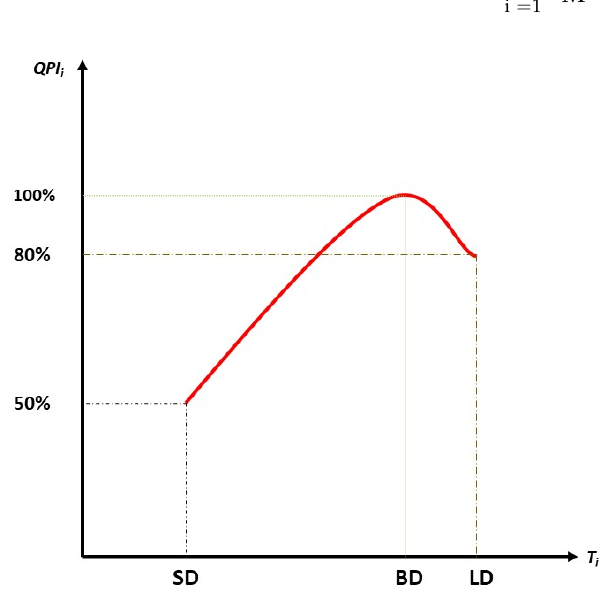
Figure 1. Quality performance index (QPI).